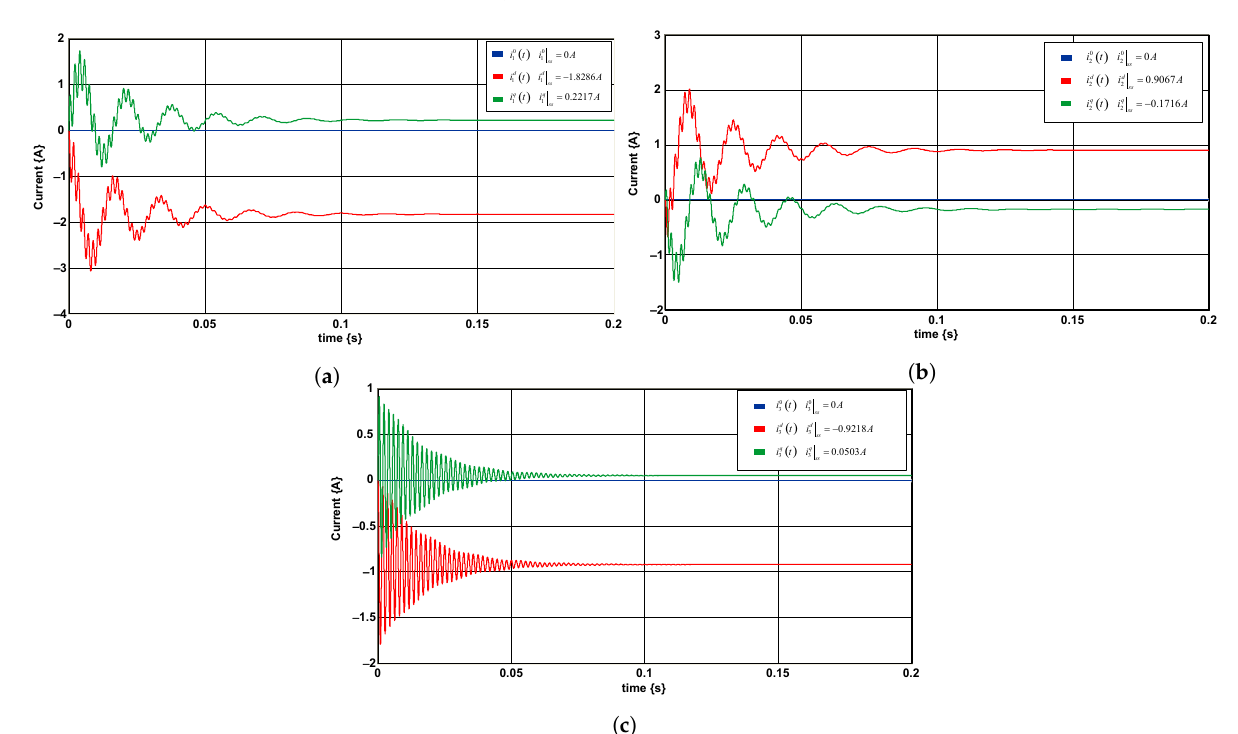
( t ) ; ( b ) i dq 0 ( t ) = f ( t ) ; ( c ) i dq 0 ( t ) = f ( t ) . ( t ) = f 3 4 10 2 3 1 The three phase currents ( a , b , c ) for each branch are shown in Figure 15. These (cid:104) (cid:105) T f 21 ( t ) f 25 ( t ) f 23 ( t ) currents are obtained from the outputs y ( t ) = where f 21 = i abc ; 1 ( t ) and f ( t ) = i abc ( t ) f 25 ( t ) = i abc 23 2 3